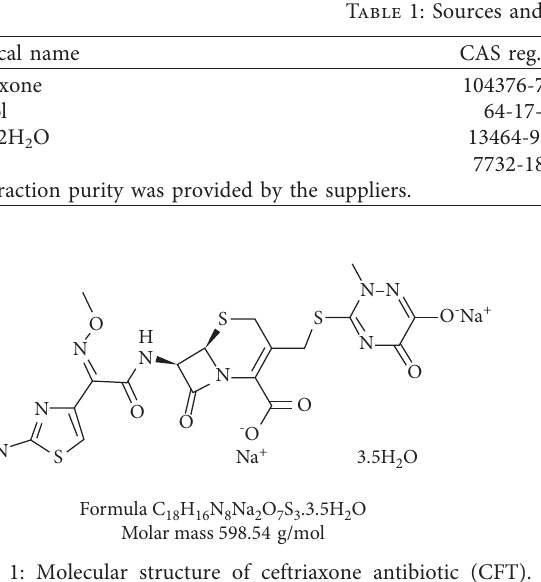
Figure 1: Molecular structure of ceftriaxone antibiotic